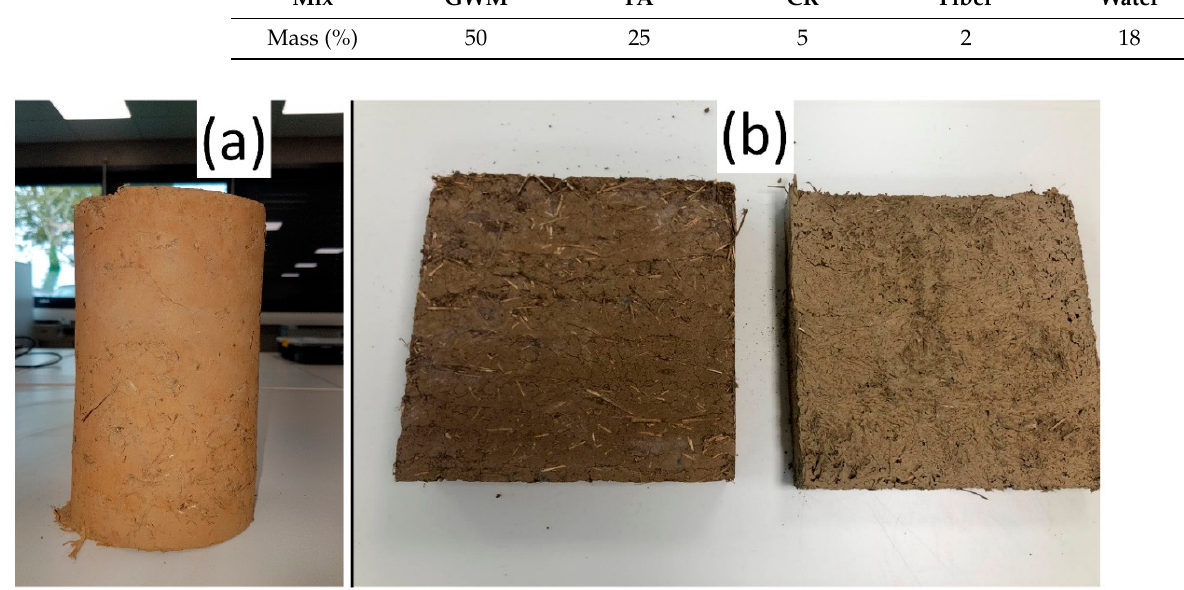
Figure 2. ( a ) Sample used for mechanical tests (Ø11 cm × 22 cm) and ( b ) samples used for thermal analysis (30 cm × 30 cm × 4 cm).